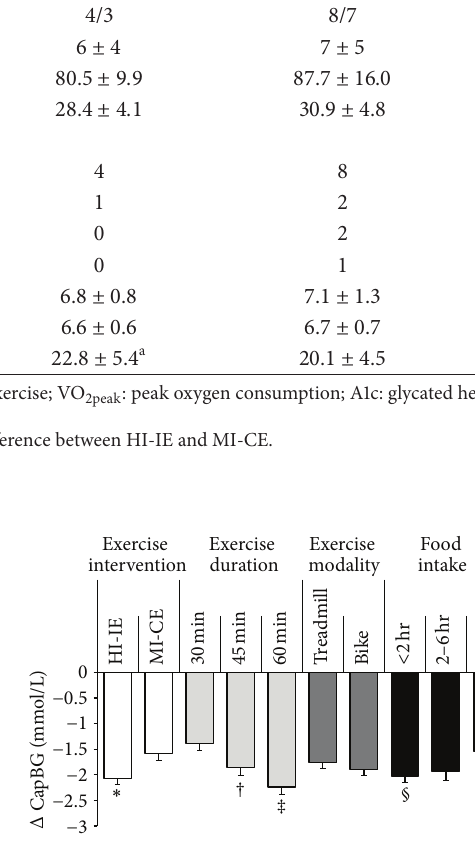
Figure 1: Effects of exercise intervention, exercise duration, exercise modality, food intake, and medication on exercise-induced CapBG reduction. Values are least square mean ± SE. ∗ HI-IE ( 𝑃 = 0.007 ),